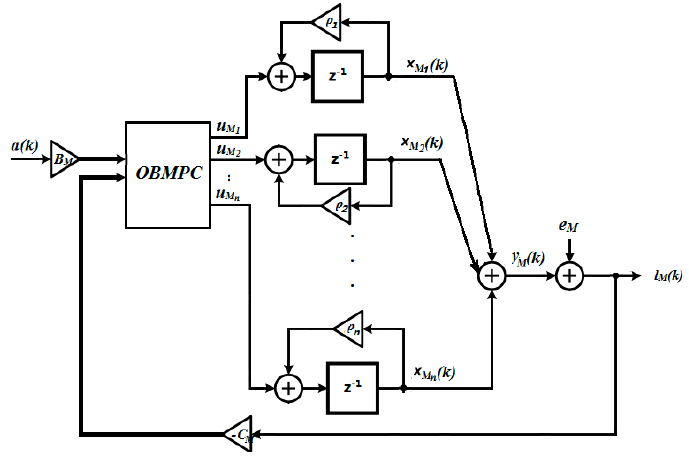
Figure 7. The OBMPC design for an nth order Δ∑ modulator (Thick lines denote vector routing).